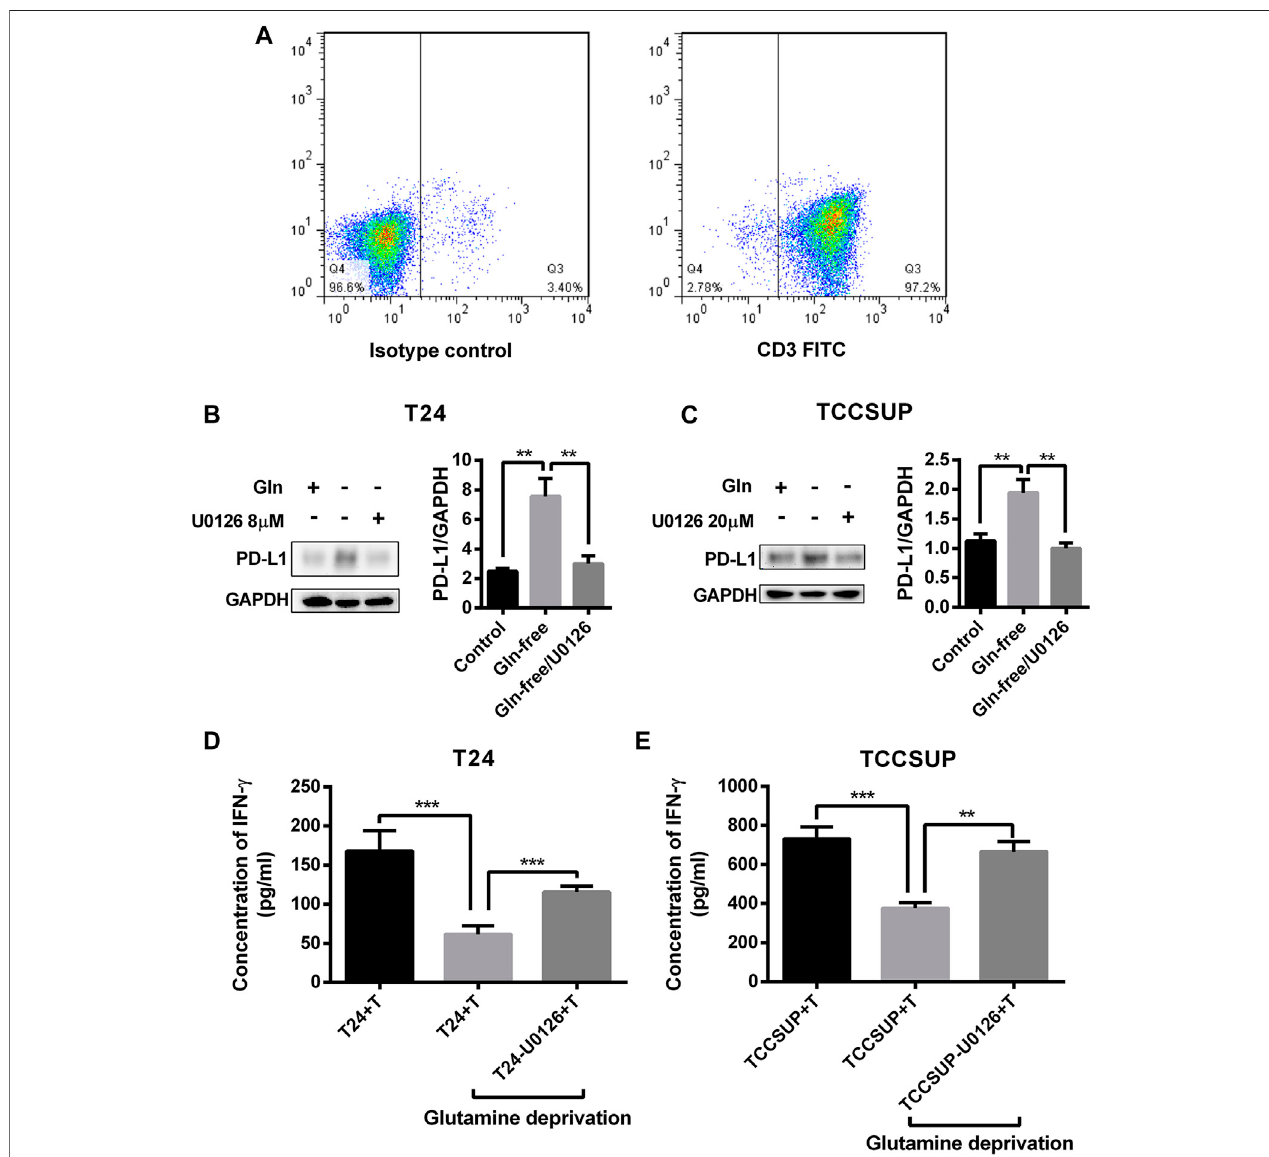
FIGURE8 | PD-L1 upregulationby glutamine deprivation in T24and TCCSUPcells decreases IFN- γ production byTcells in coculture conditions. (A) The purity of CD3 + T cells was assessed by fl ow cytometry. (B) The protein levels of PD-L1 in T24 cells after culturing in normal medium and glutamine-free culture medium with or without U0126 (8 μ M). (C) The protein expression of PD-L1 in TCCSUP cells cultured in normal medium and glutamine-free culture medium with or without U0126 (20 μ M). (D) TheproductionofIFN- γ byTcellsaftercoculturingwithT24cellsbydifferentpretreatments. (E) TheproductionofIFN- γ byTcellsaftercoculturingwith TCCSUPcellsbydifferentpretreatments.ThedensitometricanalysisofproteinswasperformedandtheresultswerenormalizedtoGAPDH.Theresultswereconsidered signi fi cant at p < 0.05 (** p < 0.01, *** p <